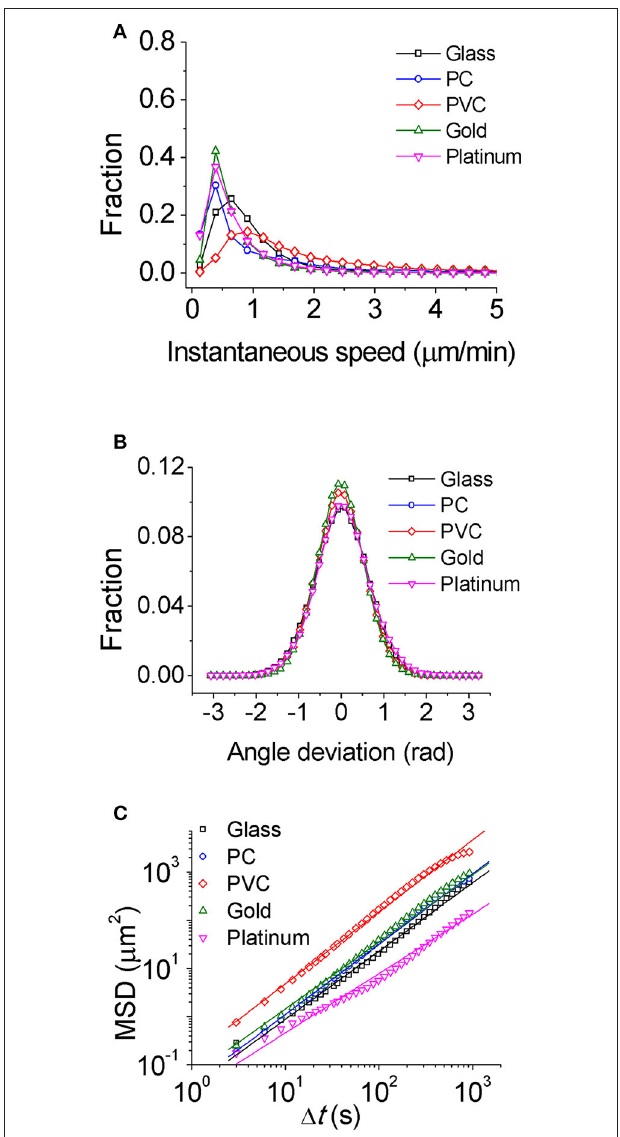
FIGURE 1 | Characterization of single-cell motility for PAO1 WT on the five chosen surfaces. (A) Instantaneous speed distributions. (B) Distributions of angle deviation. (C) Mean square displacements (MSD) of cells. The slope of MSD is 1.40 for glass, 1.42 for PC, 1.46 for PVC, 1.38 for gold, and 1.23 for platinum, respectively. The number of cells used for statistical analysis is 407 for glass, 384 for PC, 369 for PVC, 177 for gold, and 197 for platinum,